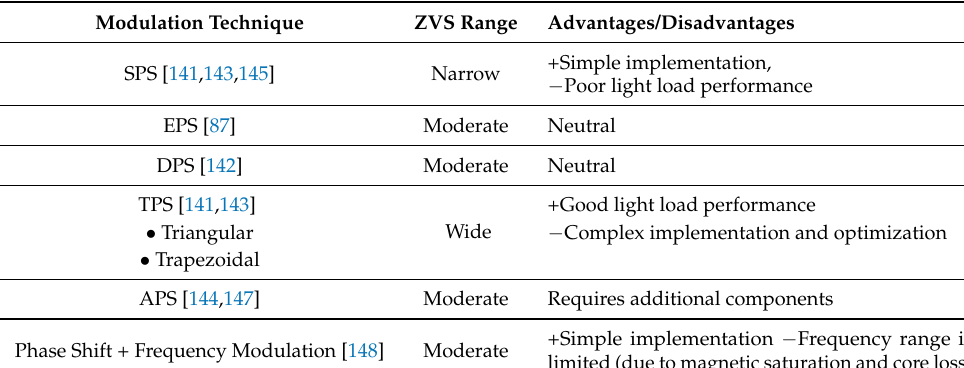
Table 9. DAB modulation